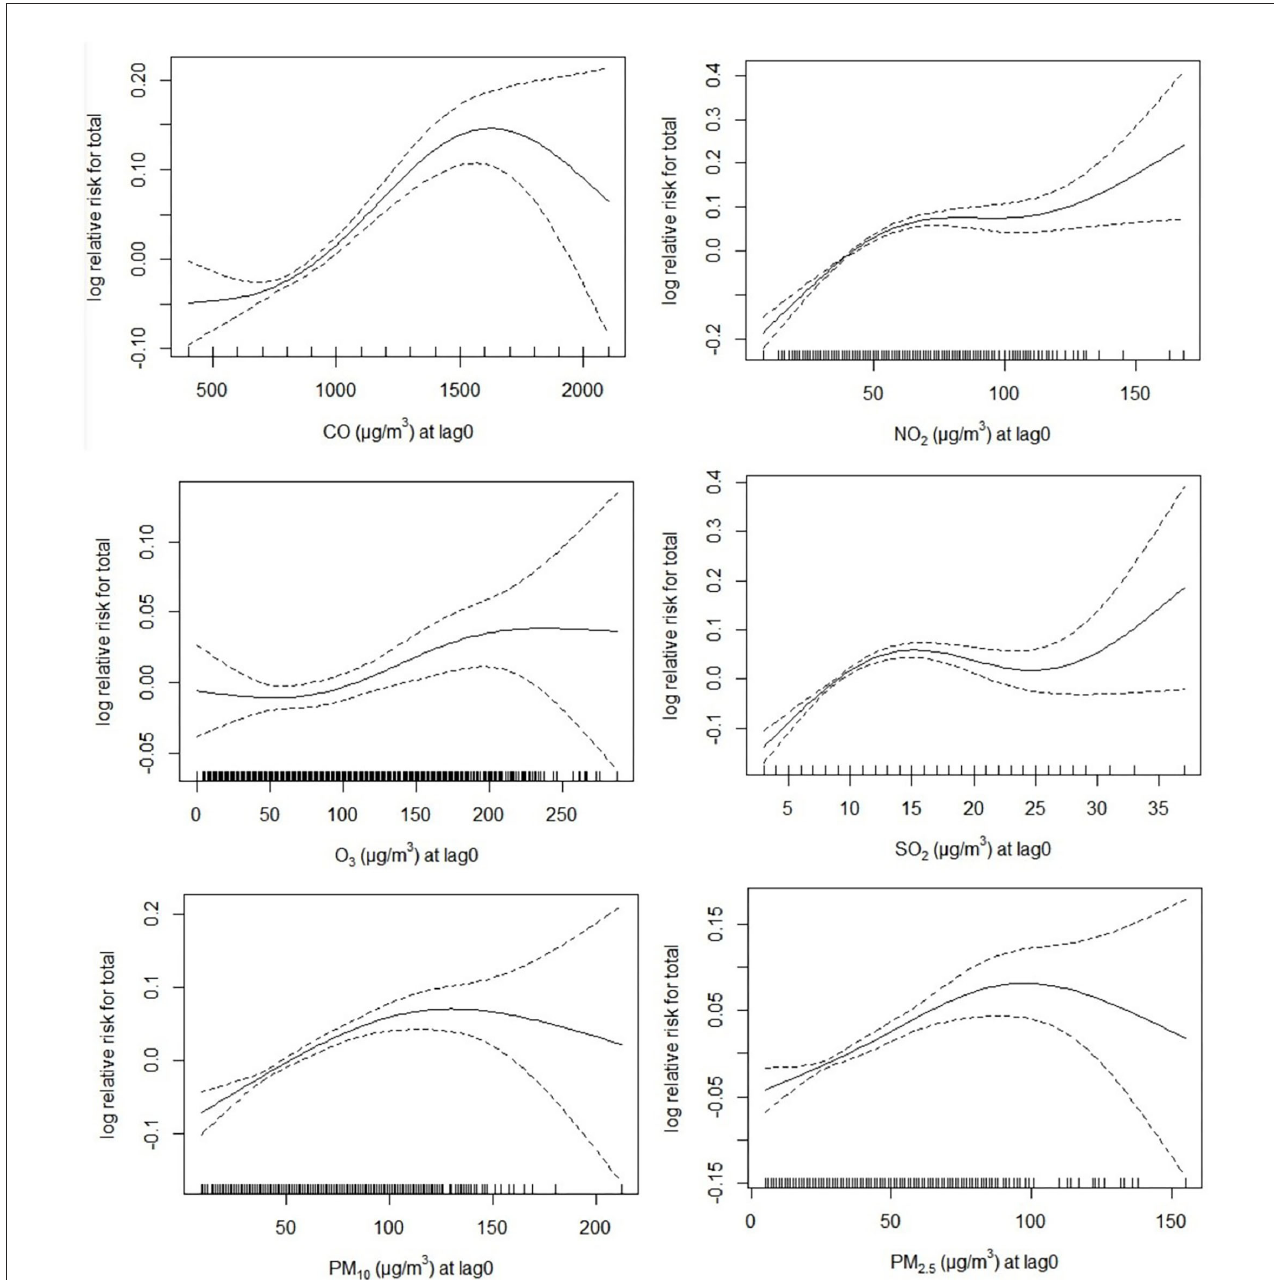
FIGURE2 The exposure–response curves of the associations of different air pollution with the risk of children’s outpatient visits in single-pollutant model. The black line represents the average relative risk of the pollutant concentration, and the dashed lines are the 95% confidence interval of the risk